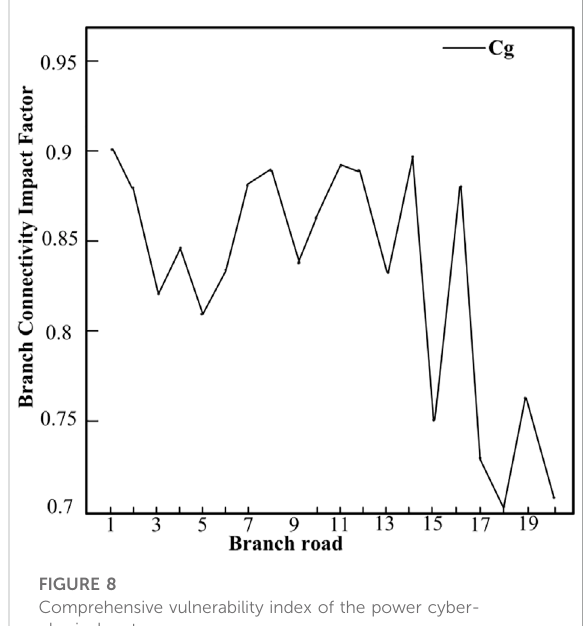
FIGURE 8 Comprehensive vulnerability index of the power cyber- physical system.